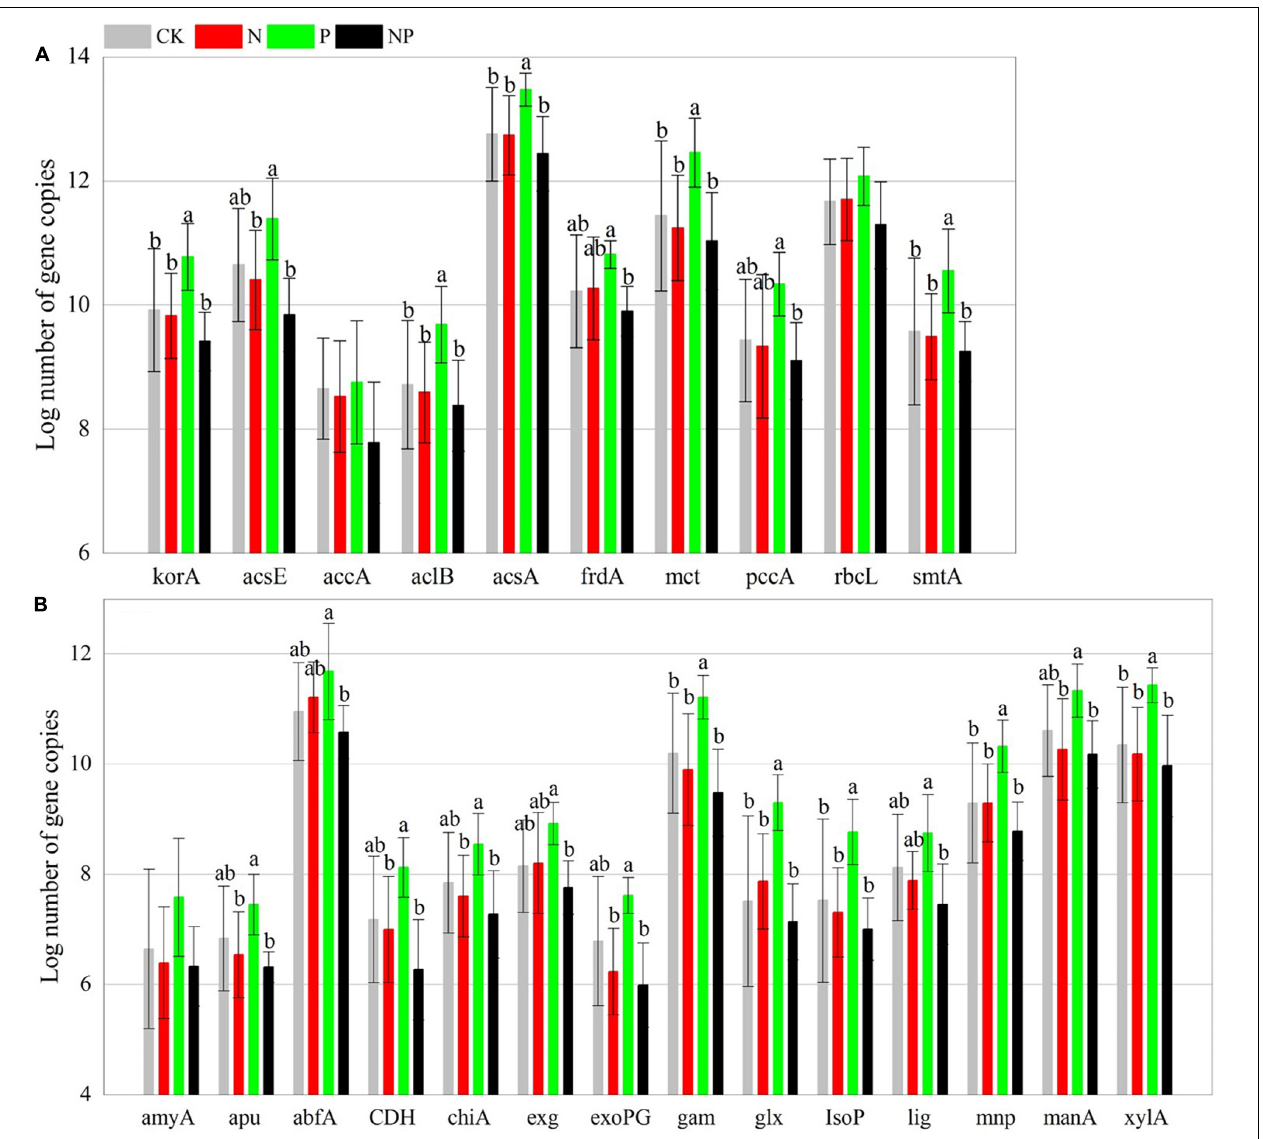
FIGURE 2 | Abundance of C fixation (A) and C degradation (B) genes among experimental treatments. Different letters indicate significant differences at a p < 0.05 level across experimental treatments. No letter indicates a non-significant difference (CK = control, N = addition of 72 kg N hm − 2 year − 1 , P = addition of 36 kg P hm − 2 year − 1 , NP = interaction of N and